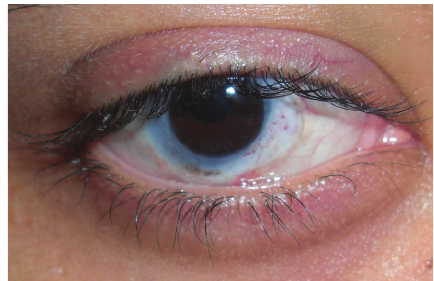
Figure 3: Patient with total limbal stem cell deficiency after chemical burn who was successfully treated with conjunctival- limbal autograft (2 years after surgery).